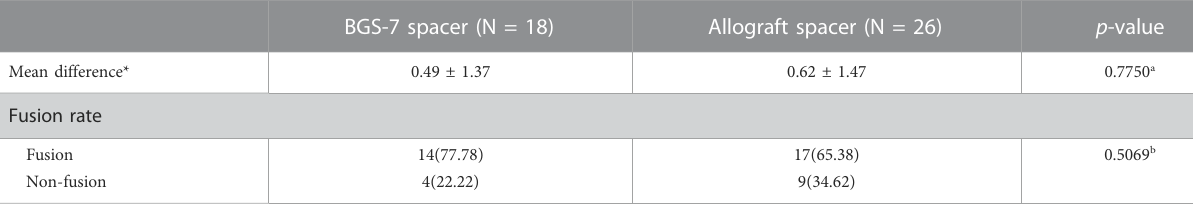
TABLE 7 Clinical